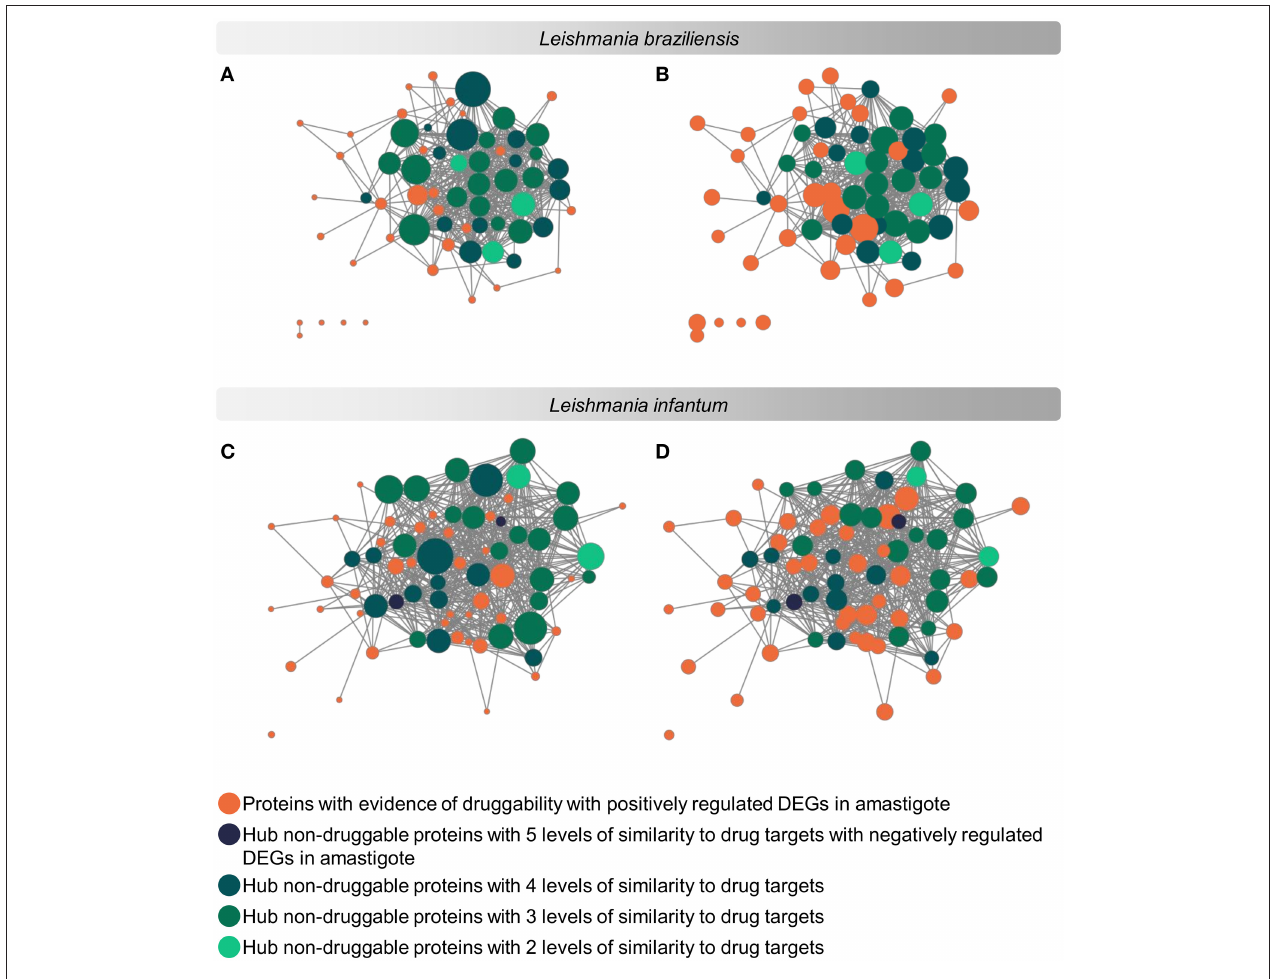
FIGURE 3 | Subnetwork of protein interaction for Leishmania sp. focused on potential drug targets and hub proteins. The complete interaction network ( Supplementary Materials 7, 8 ) was obtained from the union of protein interaction data produced in previous works of the group with the data deposited in the String database. The subnetworks were generated by selecting the hub proteins for degree centrality, hub proteins for centrality, and the potential drug targets. (A,C) : Size of the nodes reflect the Degree Centrality. (B,D) : The size of the nodes reflects the average connectivity of neighbors of a given node (Neighborhood Connectivity). The networks were noted according to the levels of similarity with known drug